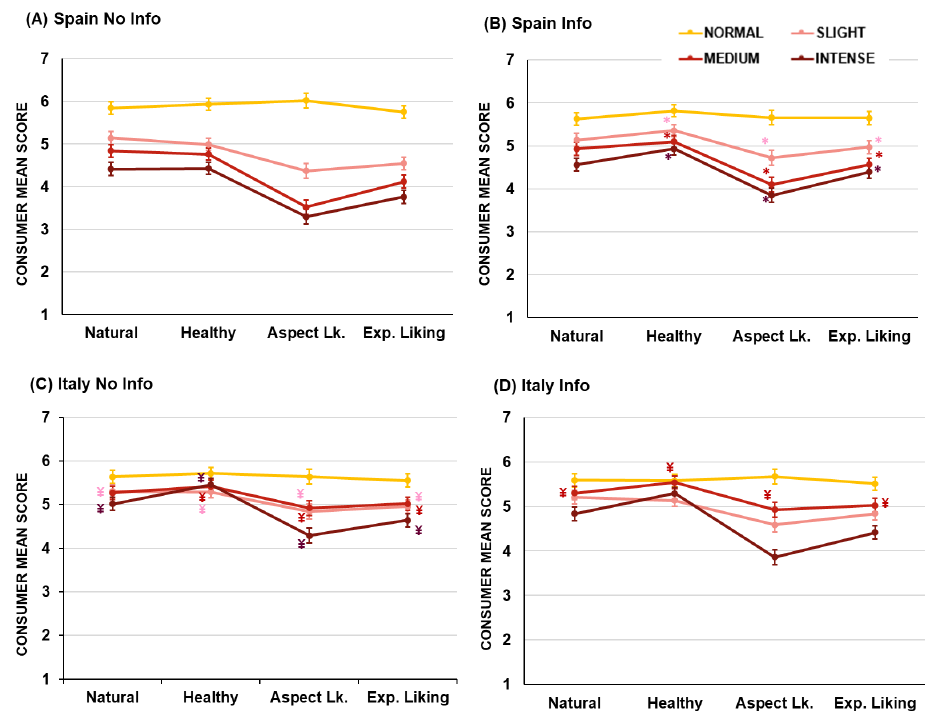
Figure 5. The mean scores of consumer perceptions of the natural and healthy characters (7-point Likert scale), and the liking of appearance and expected taste liking (7-point hedonic scale), of mandarins with different pigmentation intensities. In the four figures, vertical bars depict the LSD intervals when evaluating the pigmentation intensity effect on the scores for each aspect. * denotes significant differences between the Uninformed and Informed consumers from a specific country, i.e., when comparing the results between Figure ( A ) and ( B ), and between Figure ( C ) and ( D ). ¥ indicates significant differences between Spaniards and Italians under a specific condition (Informed or Uninformed), i.e., when comparing the results of Figure ( A ) and ( C ) and those of Figure ( B ) and ( D ) (LSD test, p -value =